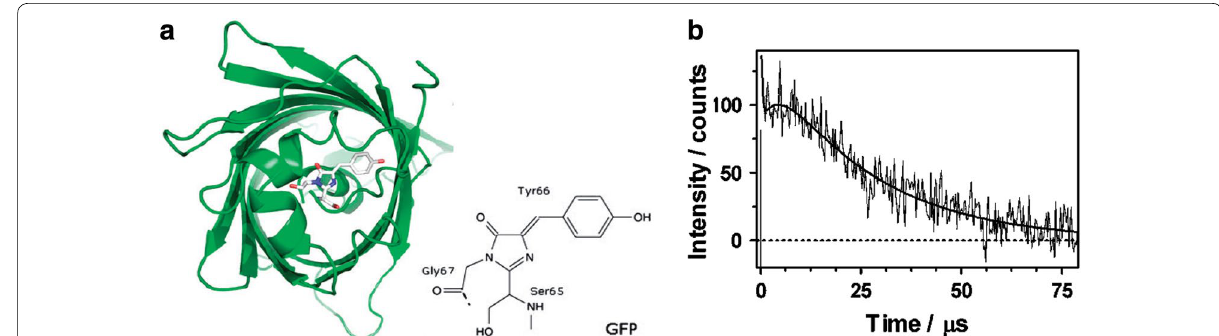
Fig. 3 a 3D structure of GFP (PDB ID: 1GFL) obtained from X‑ray crystallography and its mutant Ser65Thr (PDB ID: 1EMA). GFP has a β ‑barrel structure with the chromophore embedded in its core (Reproduced from [79] with the permission of Royal Society of Chemistry). The chromophore is shown in its neutral form with protonated phenolic oxygen. b Normalized time‑resolved phosphorescent intensity. Emission signals of 1 O 2 gener‑ ated from EGFP irradiated at λ ex 532 nm in deuterated phosphate‑buffered saline (d‑PBS) (1:3) were detected at λ = [63] with the permission of